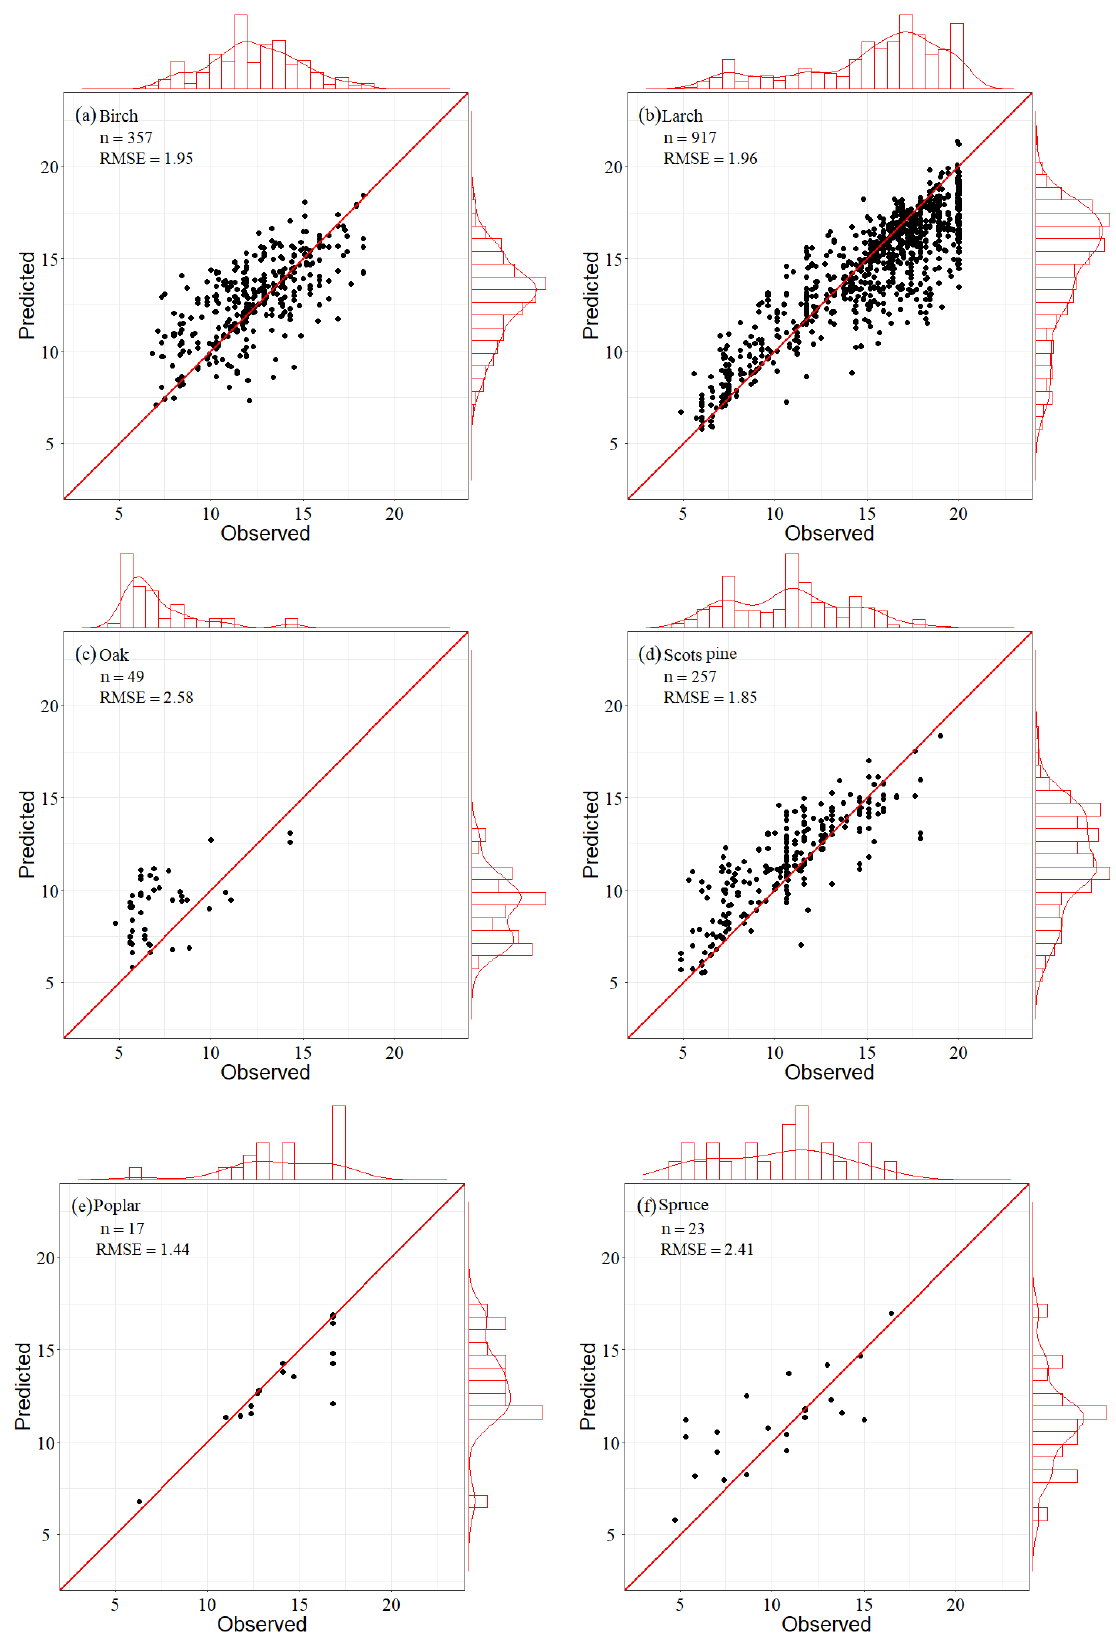
Figure 9. Scatter plots of the predicted forest canopy height by stacking of ( a ) birch, ( b ) larch, ( c ) oak, ( d ) Scots pine, ( e ) poplar, and ( f ) spruce.